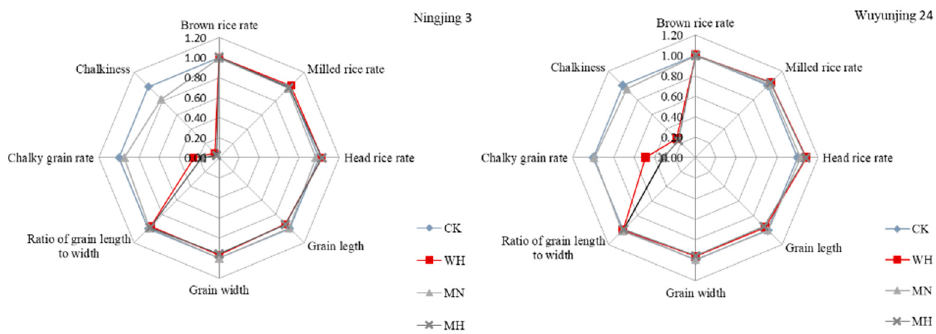
Figure 7. Illustration of high-temperature and exogenous MeJA on rice quality traits. Note: CK: natural temperature and sprayed with water; MN: natural temperature and sprayed with MeJA; WH: heat stress and sprayed with water; MH: high temperature and sprayed with MeJA.